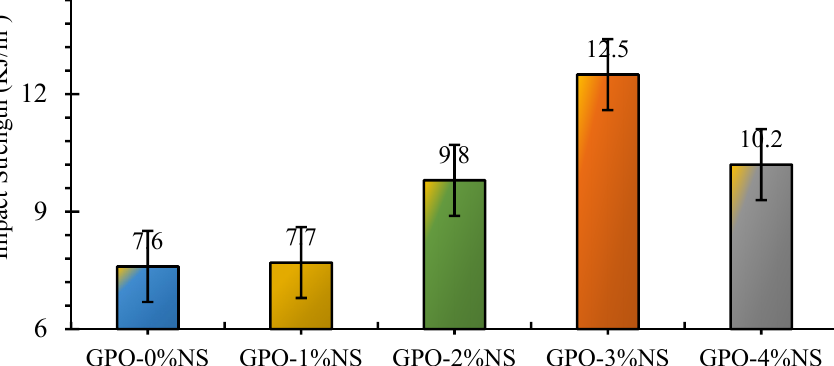
Figure 17. Variation in IMS of carbon-fiber-reinforced GPO composite paste with different propor- tions of NS.